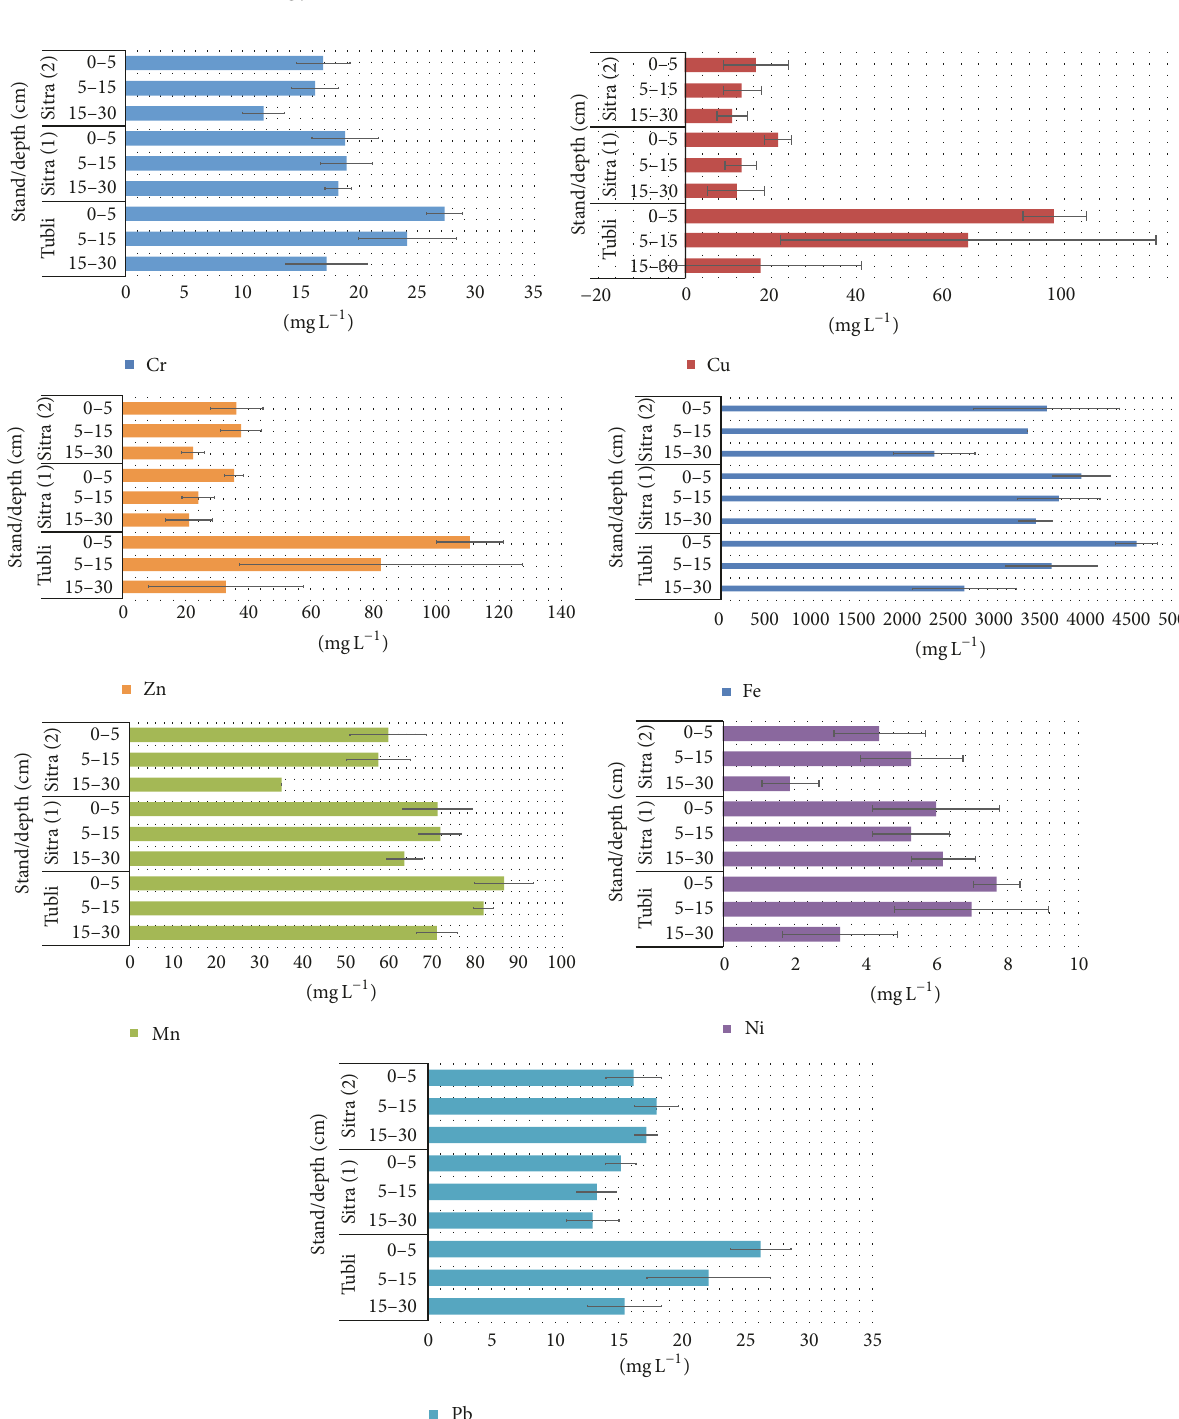
Figure 3: Heavy metals content of mangrove sediment in the study sites (mg L −1